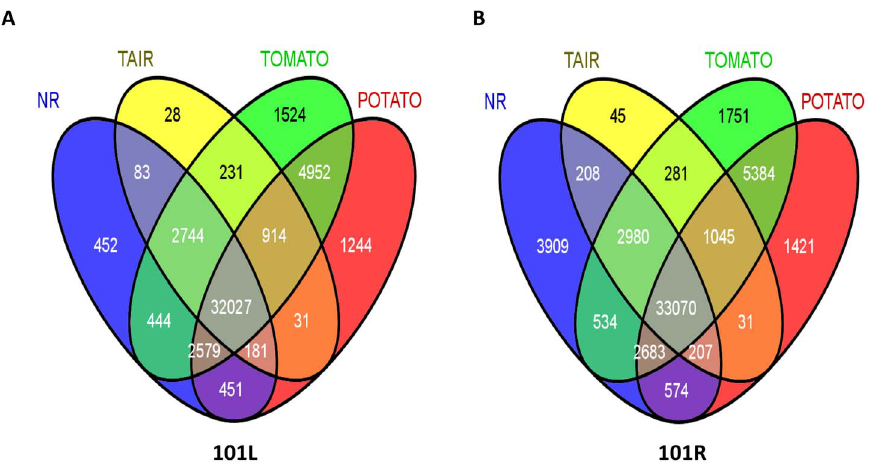
Figure 2. The number of unigenes of 101L (A) and 101R (B) transcriptomes annotated using TAIR10, NR, tomato and potato databases.